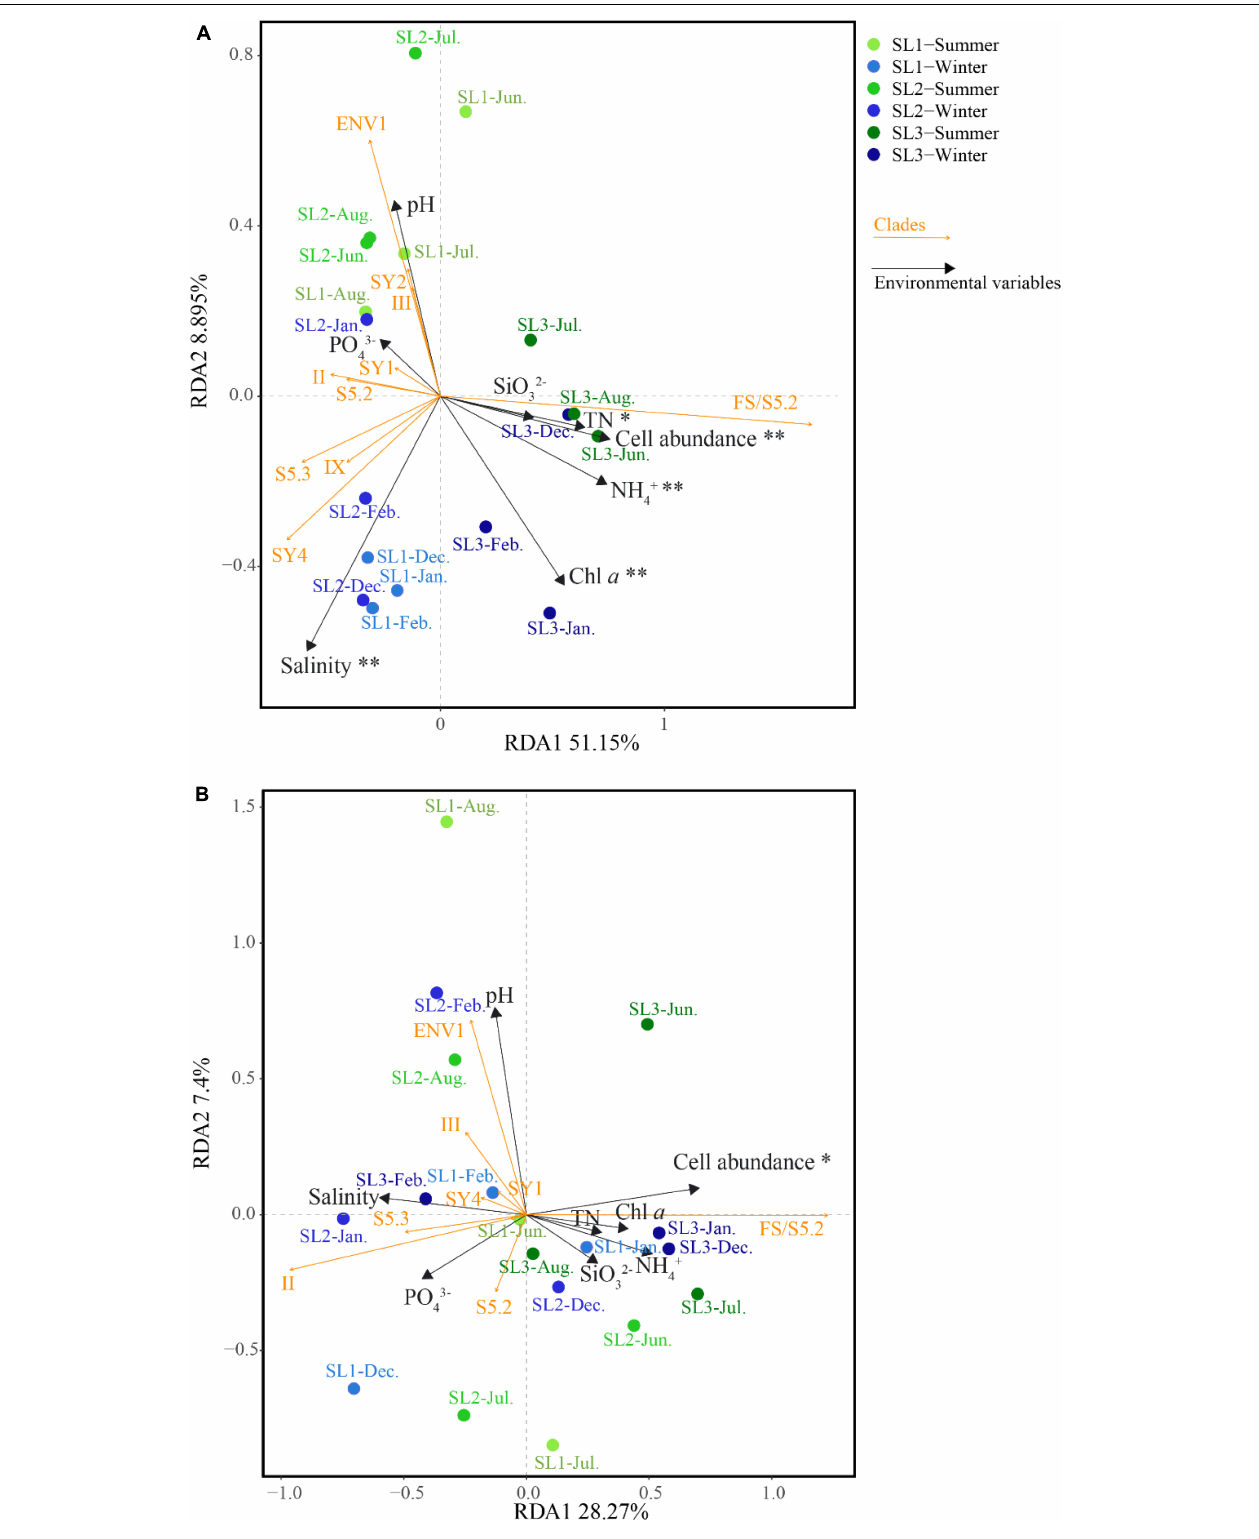
FIGURE 6 | Correlation plots based on the RDA revealing the relationship among stations, environmental variables, and Synechococcus lineages at DNA (A) and cDNA (B) levels. * – p < 0.05; ** – p < 0.01.